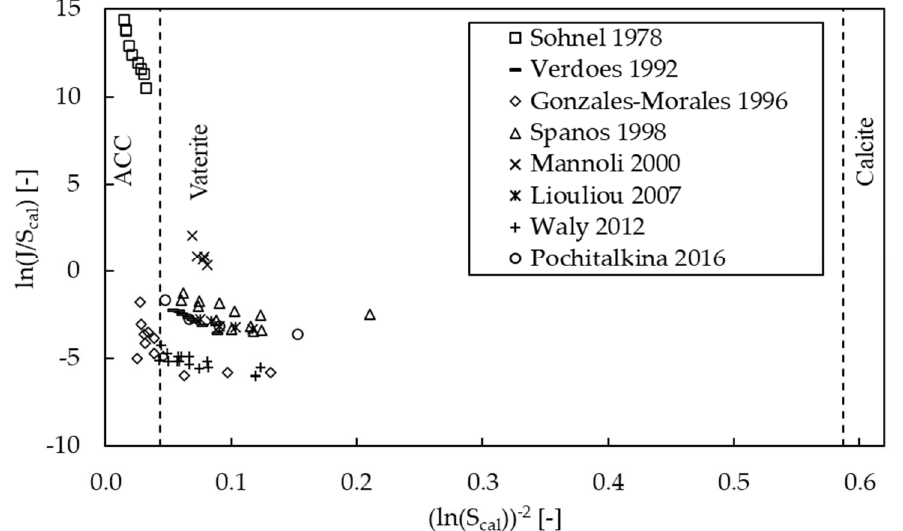
Figure 7. Linearized nucleation rates plotted against the recalculated calcite saturation. Most data are now centered in three groups. One completely in the vaterite regime, one completely in the ACC regime and one group passing over this polymorph change. There are no nucleation data for the calcite regime, although several publications report about calcite nucleation.